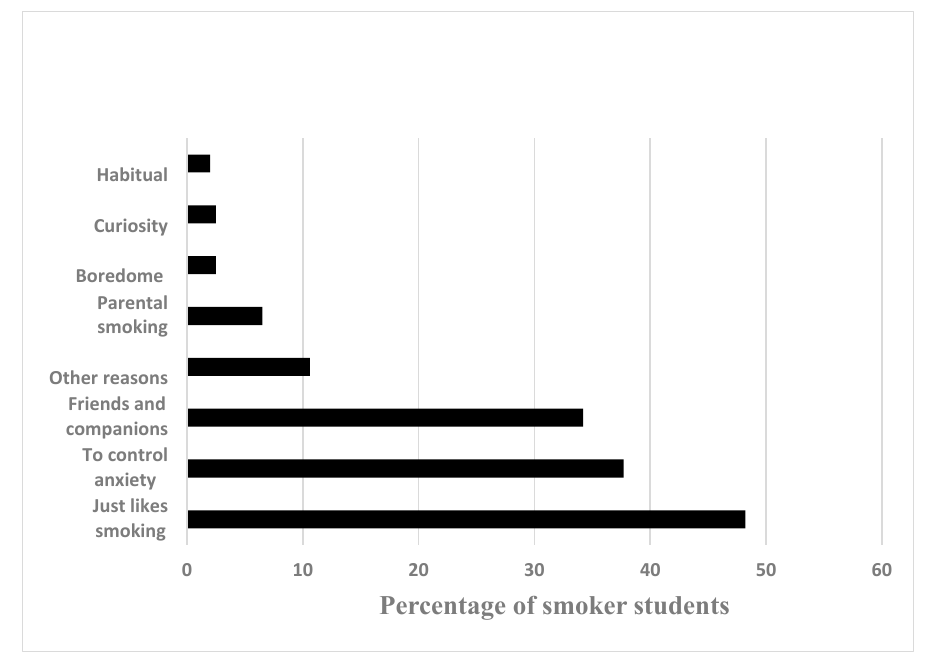
Figure 1. The perceived reasons for becoming a smoker.